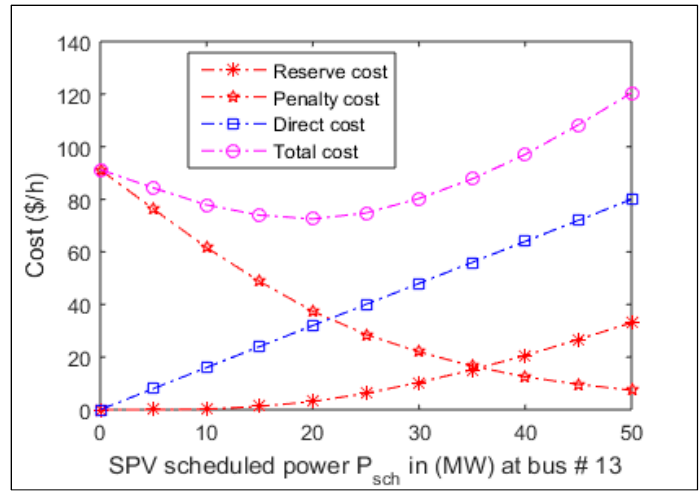
Figure 12. Cost vs. SPV schedule power (MW) (bus#13).